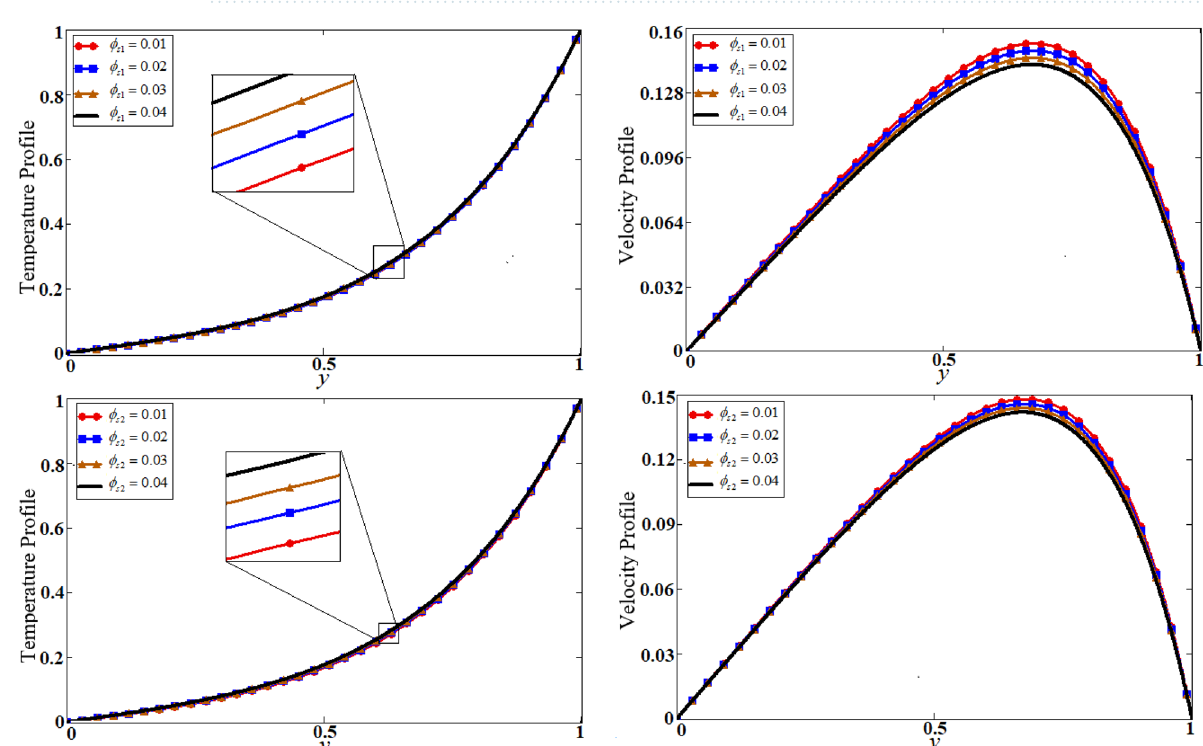
Figure 5. Results of volume fractional of both nanoparticles on temperature and velocity.